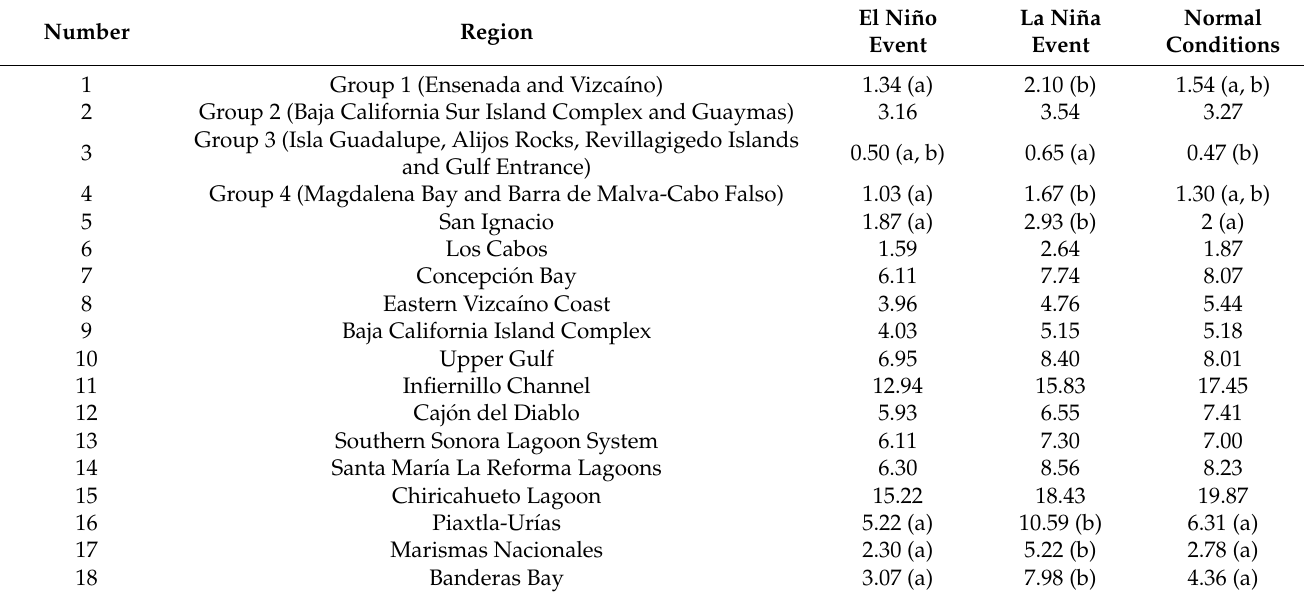
Table 5. Pairwise Permutation Test for the mean monthly winter chlorophyll a (Chl a ) values during El Niño and La Niña events, as well as in normal conditions, in the regions of the Northwest Pacific Ocean, Mexico. Columns sharing the same letter (for a fixed row) are not statistically